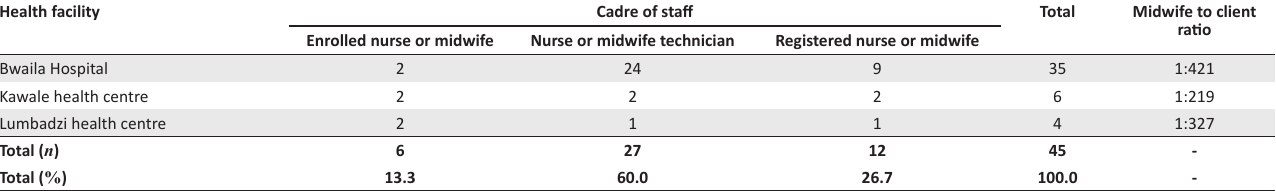
TABLE 2: Cadre of midwives and midwife to client ratio for each health facility. Health facility